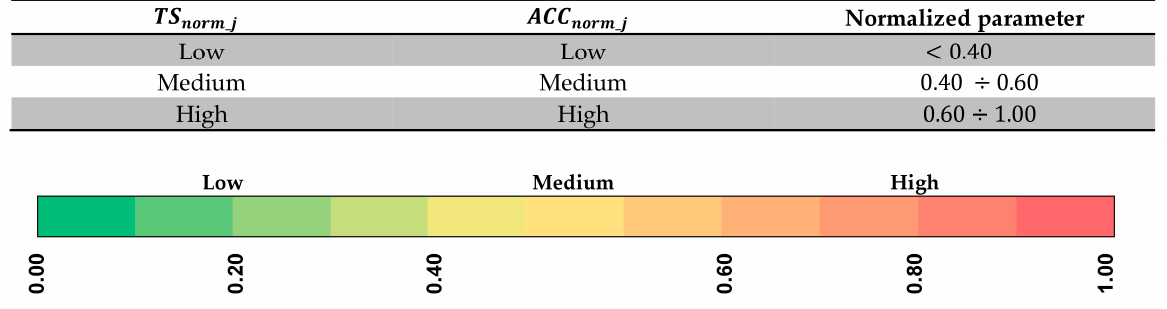
Figure 2. Normalized Total Score and Normalized Accident Rate Chromatic scale.